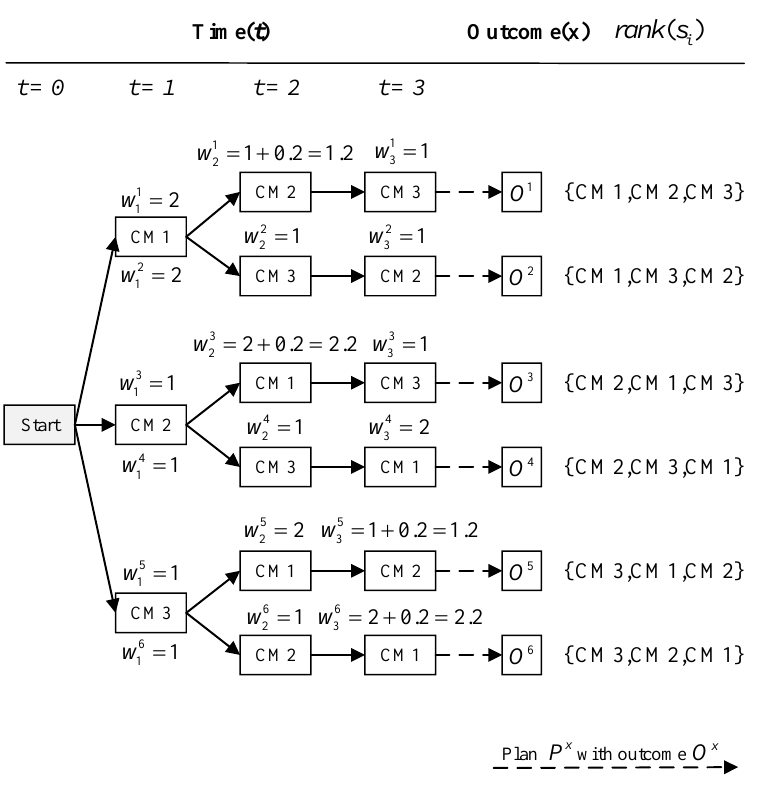
Figure 5. The search tree starting at time step t =